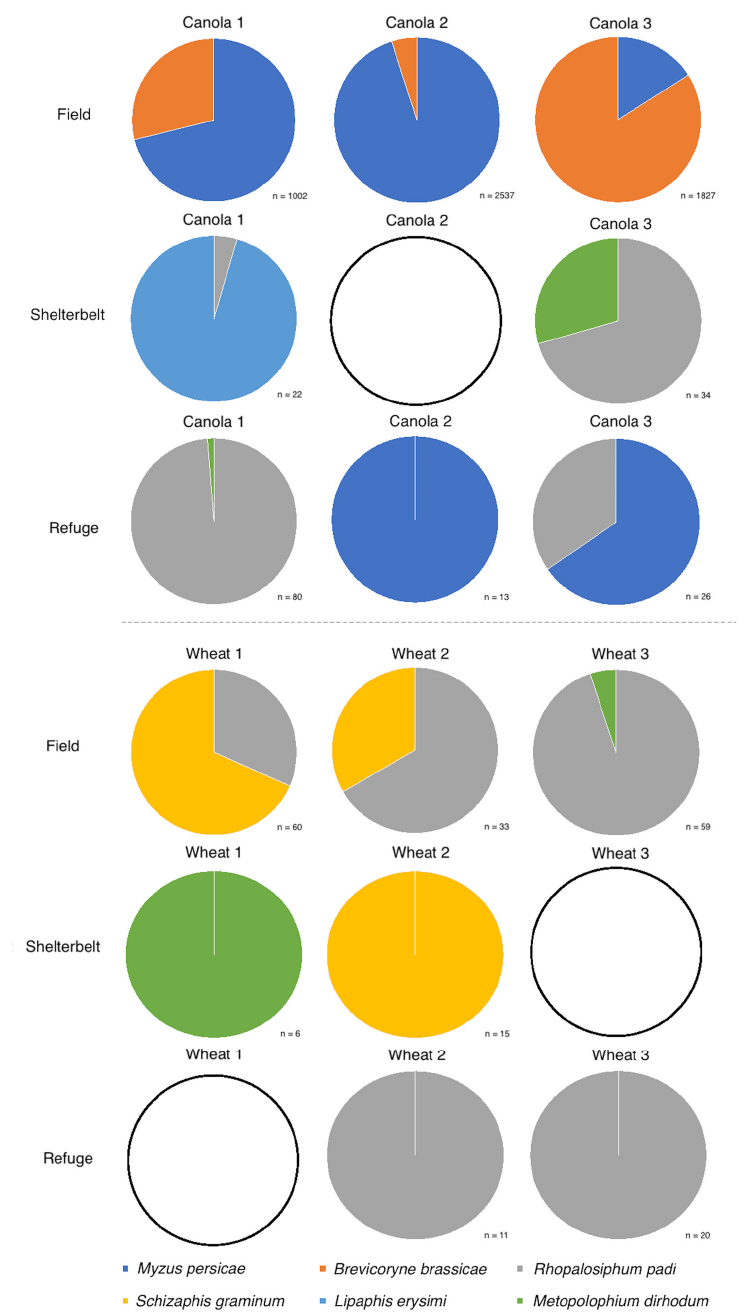
Figure 5. Aphid species composition from two-minute direct sampling undertaken in canola and wheat crops in 2018. n = number of aphids sampled. Where n < 5, pie charts are shown as empty